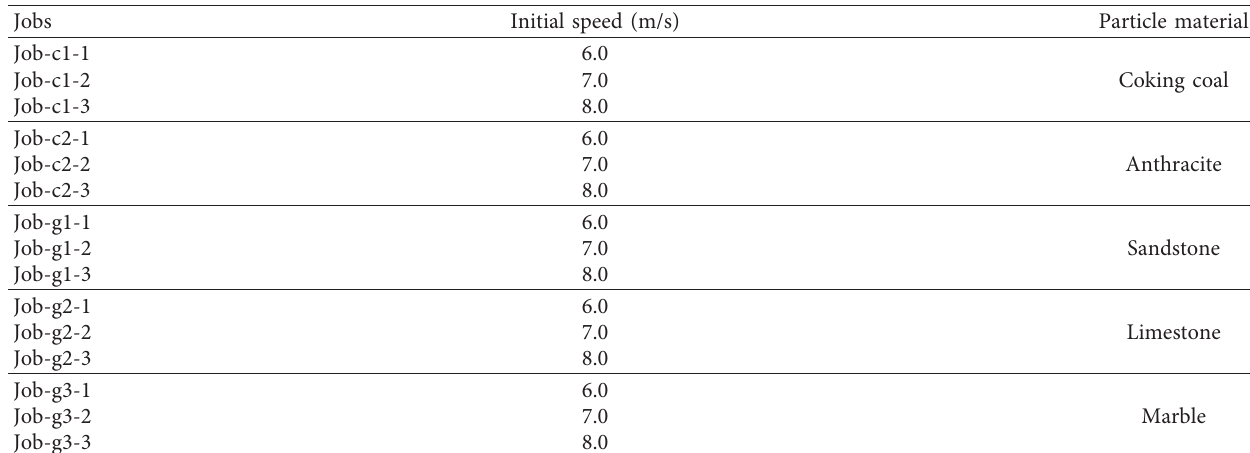
Table 5: Settings of the simulation